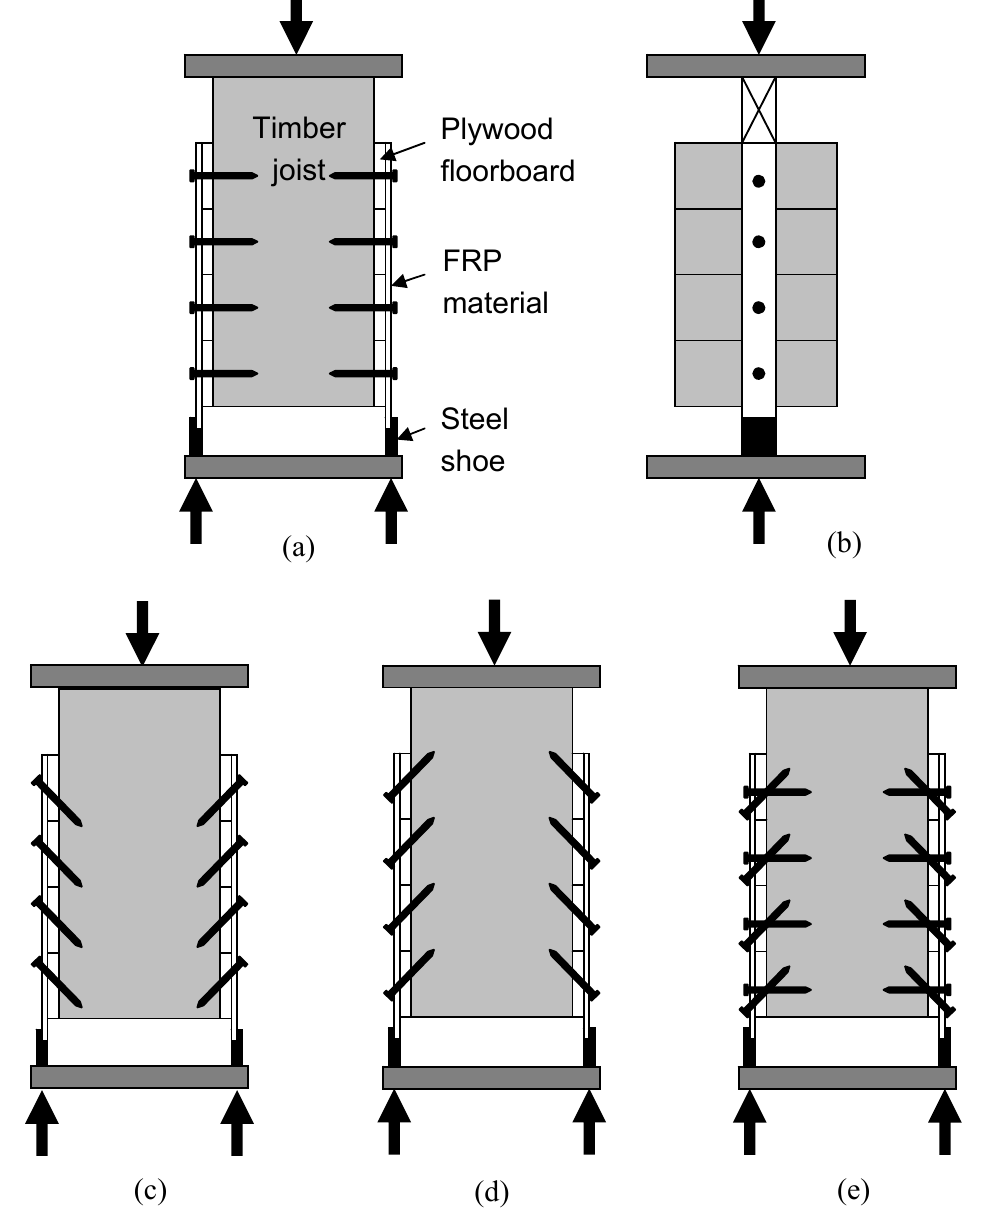
Figure 14. (a) Front view of Specimen 1. (b) Side view of Specimen 1. (c) Specimen 2. (d) Specimen 3 (e) Specimen